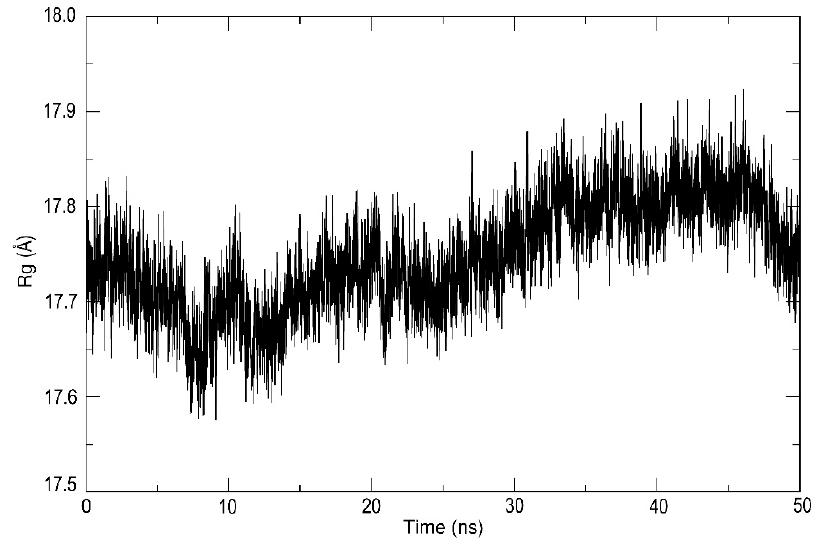
Figure 6. The radius of gyration (Rg) of the main chain atoms of LinB D147C+L177C during MD simulation at 300K.